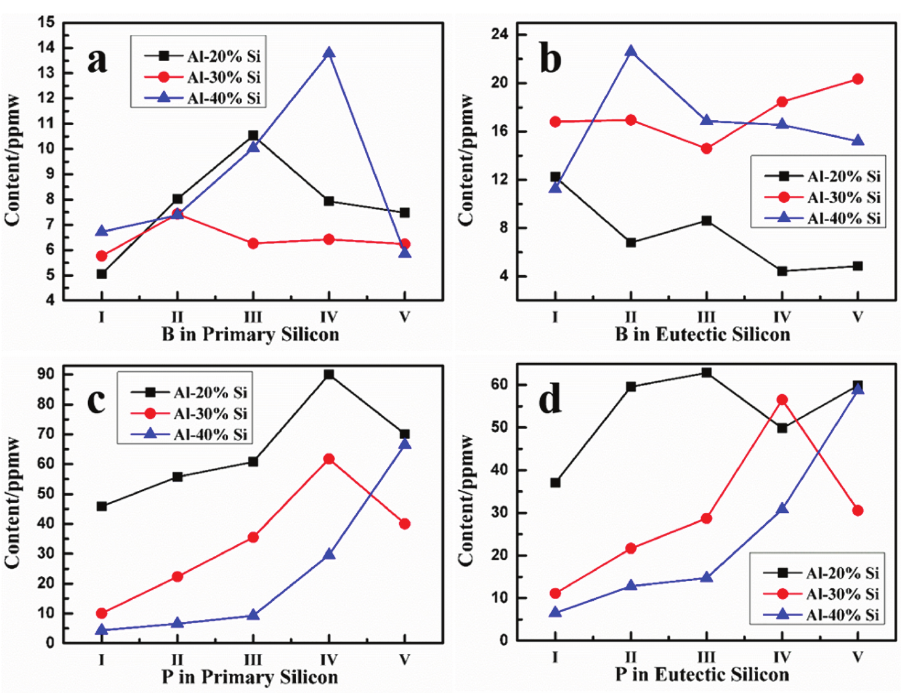
Figure 6: Distribution of B and P in five different parts from bottom to top of ingots. (a) B in primary Si flakes; (b) B in eutectic Si powders; (c) P in primary Si flakes; and (d) P in eutectic Si